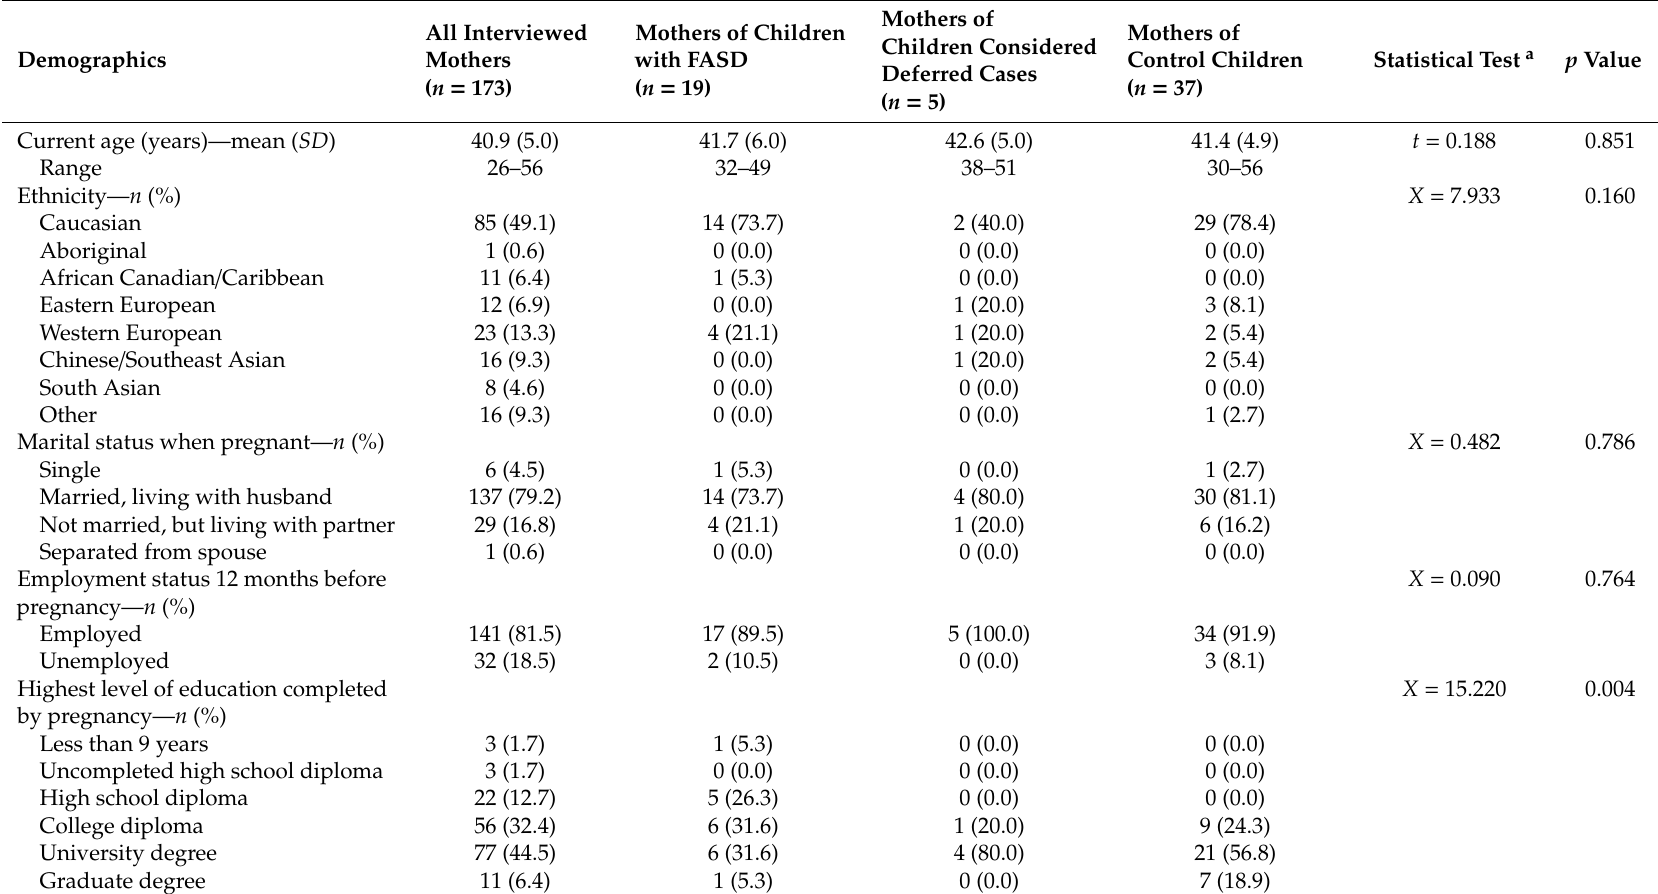
Table 1. Maternal demographic characteristics of all interviewed mothers, mothers of children with FASD, and mothers of control